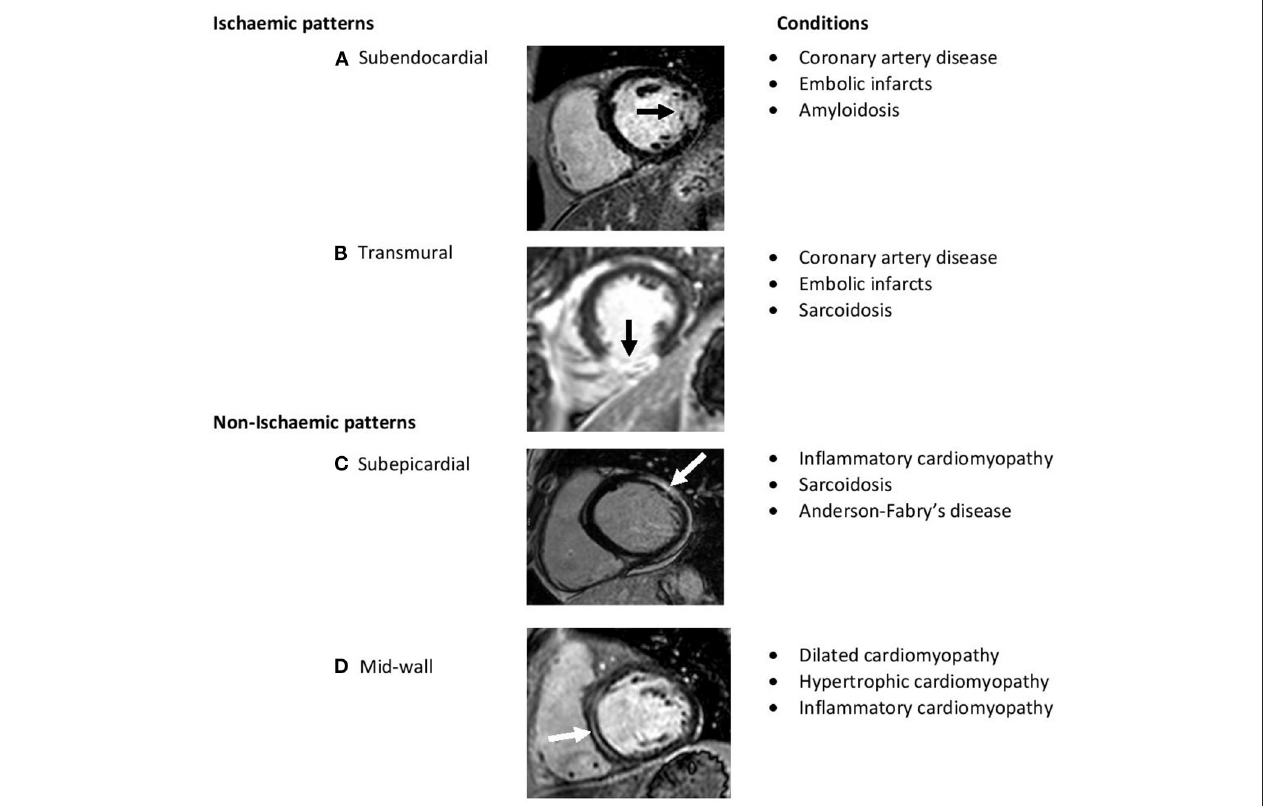
FIGURE 3 | Short-axis late-gadolinium-enhanced CMR images demonstrating hyperenhancement (arrows) indicative of scar. The differing patterns help characterize various myocardial diseases. (A,B) Represent typical ischaemic scar pattens involving subendocardium. (C,D) Represent non-ischaemic scar patterns which typically involve epicardium to mid